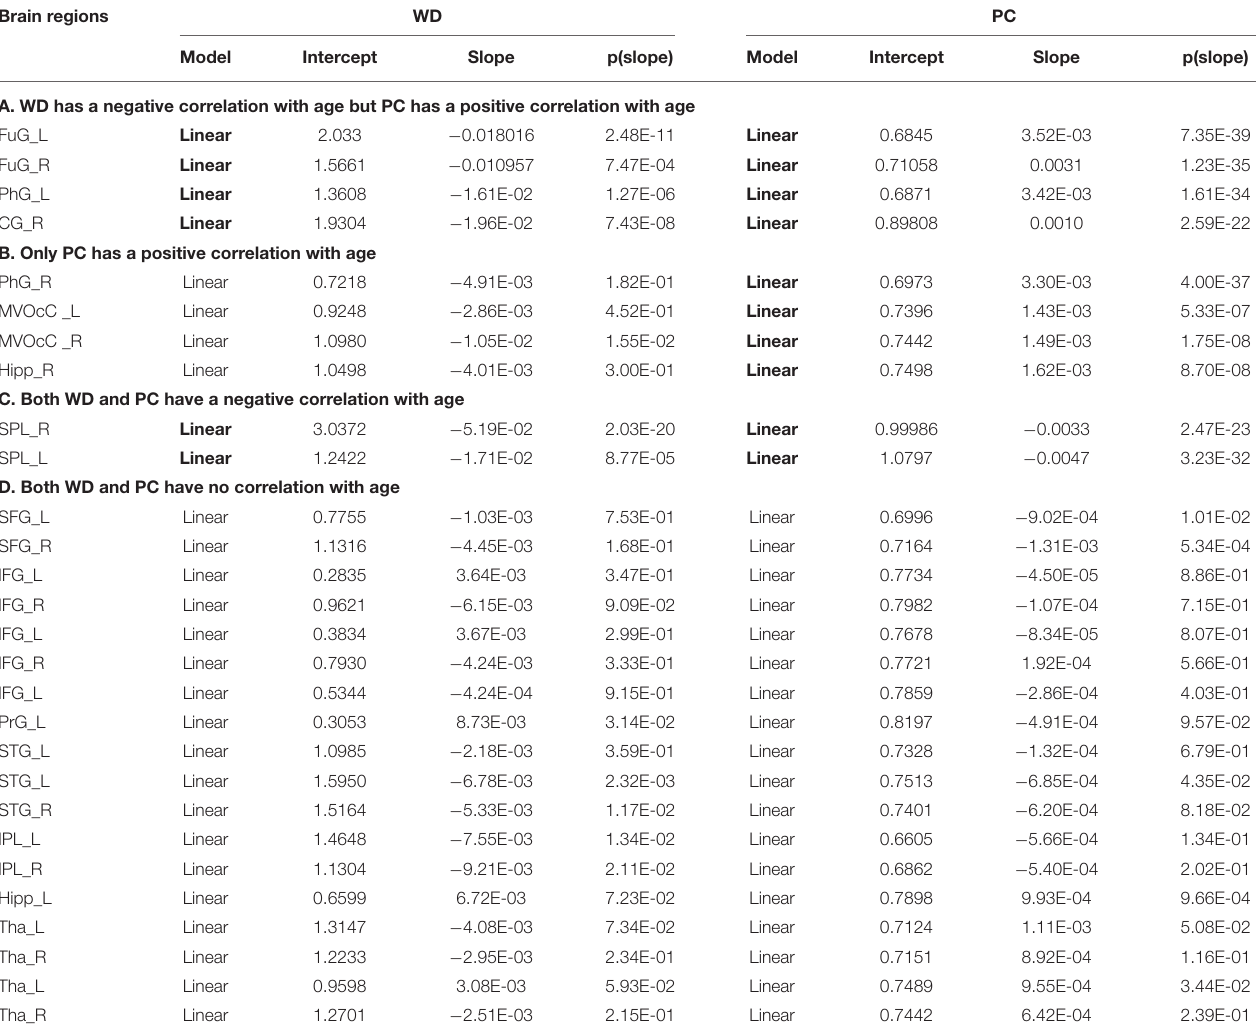
TABLE 2 | Fitted correlation curves of WD and PC of selected hubs in the Middle - Old age stage. Brain